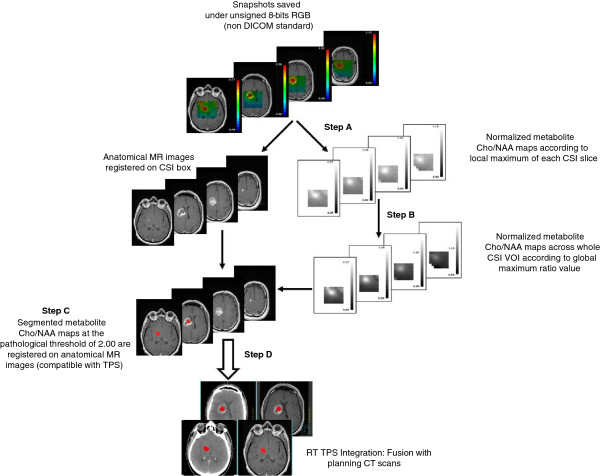
Flow chart of the image processing steps to integrate MRSI-defined regions with abnormal Cho/NAA ratio values into RT TPS.